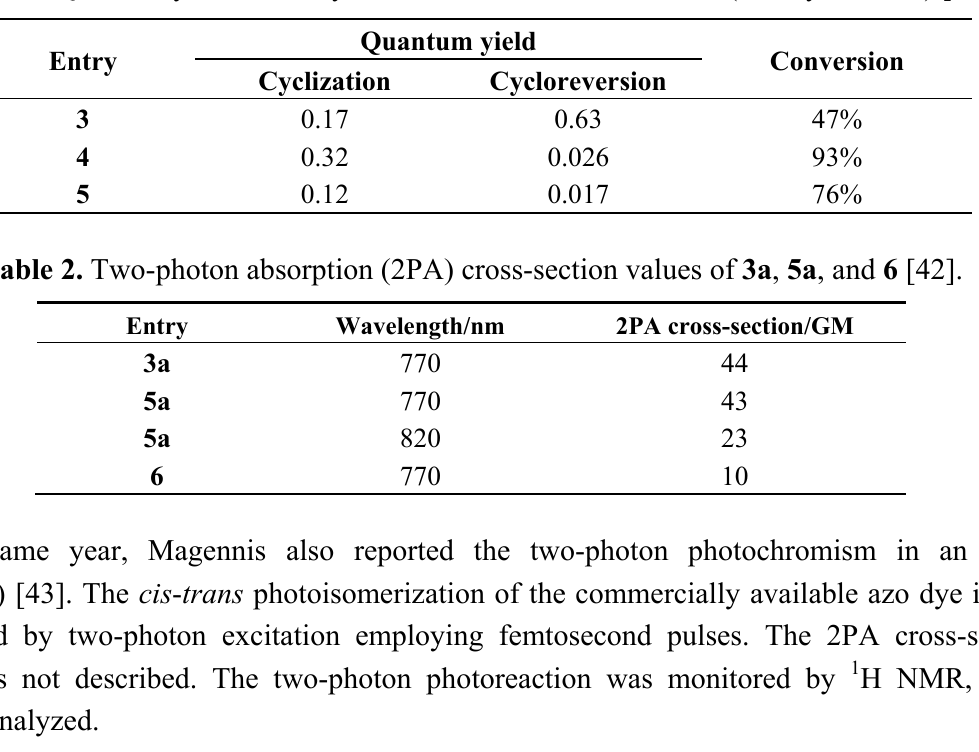
Table 1. Quantum yields of diarylethene derivatives 3 – 5 in THF (tetrahydrofuran) [42].